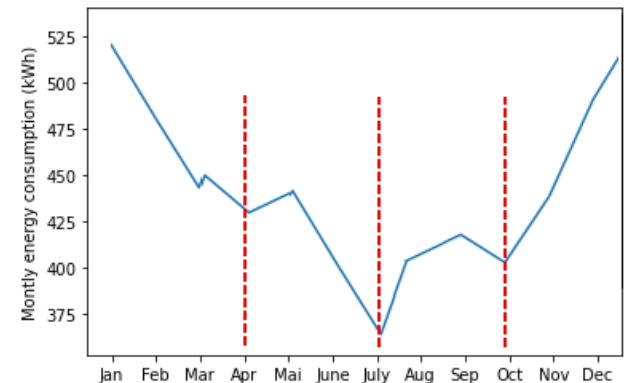
Figure 2. Average monthly energy consumption by